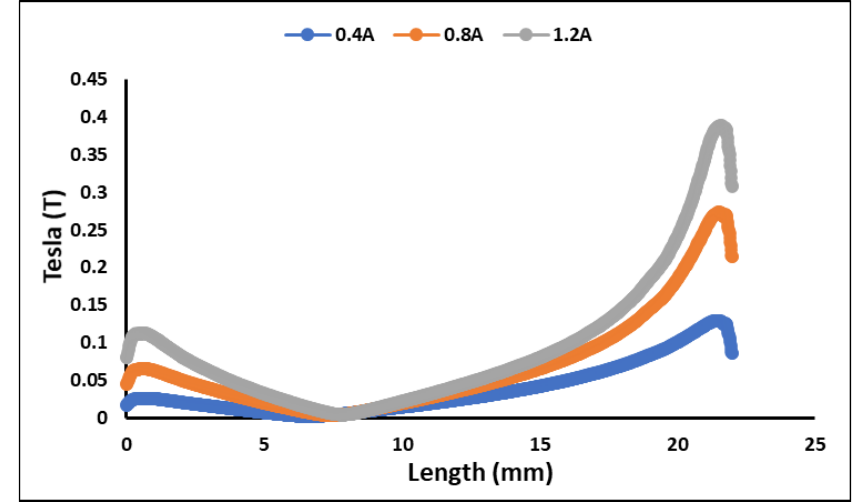
Figure 5. Flux Density value in MR brake’s fluid gap.